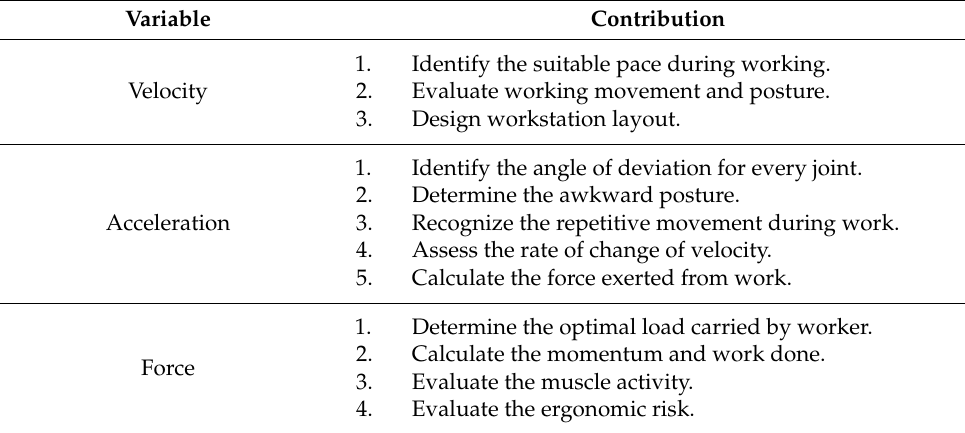
Table 4. Summary for the contribution of the kinetic and kinematic variables to the ergonomic risk